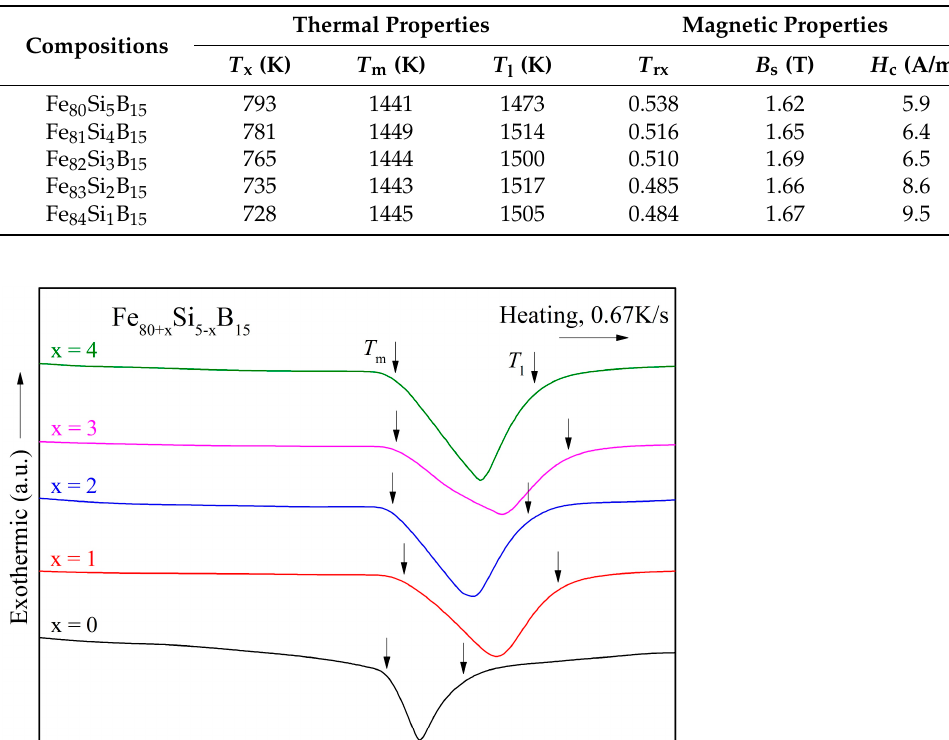
Figure 7. DSC curves of the melting processes for the Fe 80+x Si 5 − x B 15 ( x = 0–4) alloys.